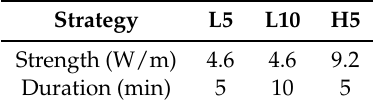
Figure 1. Particle size distribution of the sand used for testing AHFO soil moisture estimation. Table 1. The strength and the duration of the pulse in the three heating